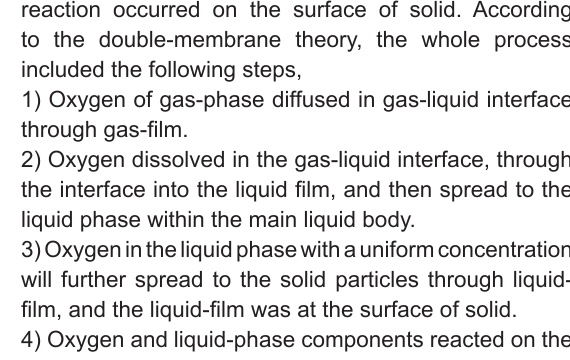
Figure 5. Potential—pH of Mn—O system in aqueous solution at 80ºC